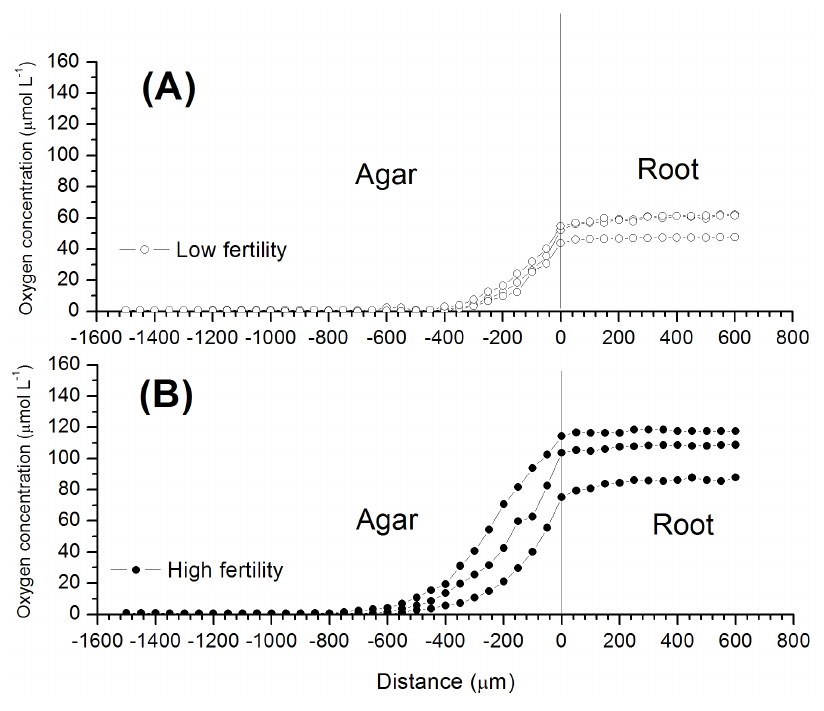
Figure 5. A representative graph showing oxygen profiles of the rhizosphere and within the rice root, 50 d after germination, growing in the (A) low- and (B) high-fertility soils at 20 6 C. The rice plant roots were separated from the soil and placed in agar with a nutrient solution. Newly formed roots with uniform 45-mm lengths were selected, and both were measured at a position 25 mm away from the root tips. The average diameters of the roots growing in the low- and high-fertility conditions were 0.74 and 0.93 mm at the measured points, respectively. The measurements were repeated in different rice plants and with different newly formed roots, with lengths ranging from 30 to 55 mm. An OXY10 oxygen microelectrode (Unisense, Aarhus, Denmark [31]) 8–10 m m in diameter was used to penetrate the rice root longitudinally. Three rhizoboxes were used for the individual rice root ROL measurements. Each curve shown in the figure indicates an individual rice root.